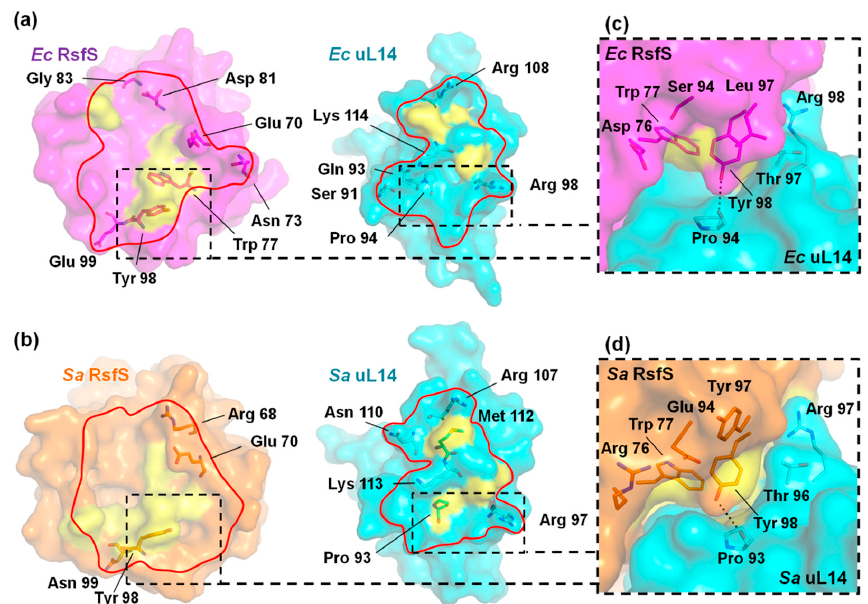
Figure 4. The interaction interfaces of the RsfS–uL14 heterodimer in the cryo-EM complex: ( a ) E. coli (PDB: 7BL4); ( b ) S. aureus (PDB: 6SJ6). The interaction surfaces between RsfS and uL14 are represented by the red border. Hydrophobic regions are shown as yellow surfaces and contacting H-bond-forming amino acids are shown as sticks. The heterodimer contacting surfaces around Y98 of RsfS from E. coli ( c ) and S. aureus ( d ) are shown in the zoomed boxes. H-bonds are represented by black dashed lines; the water molecule is represented by a red ball.